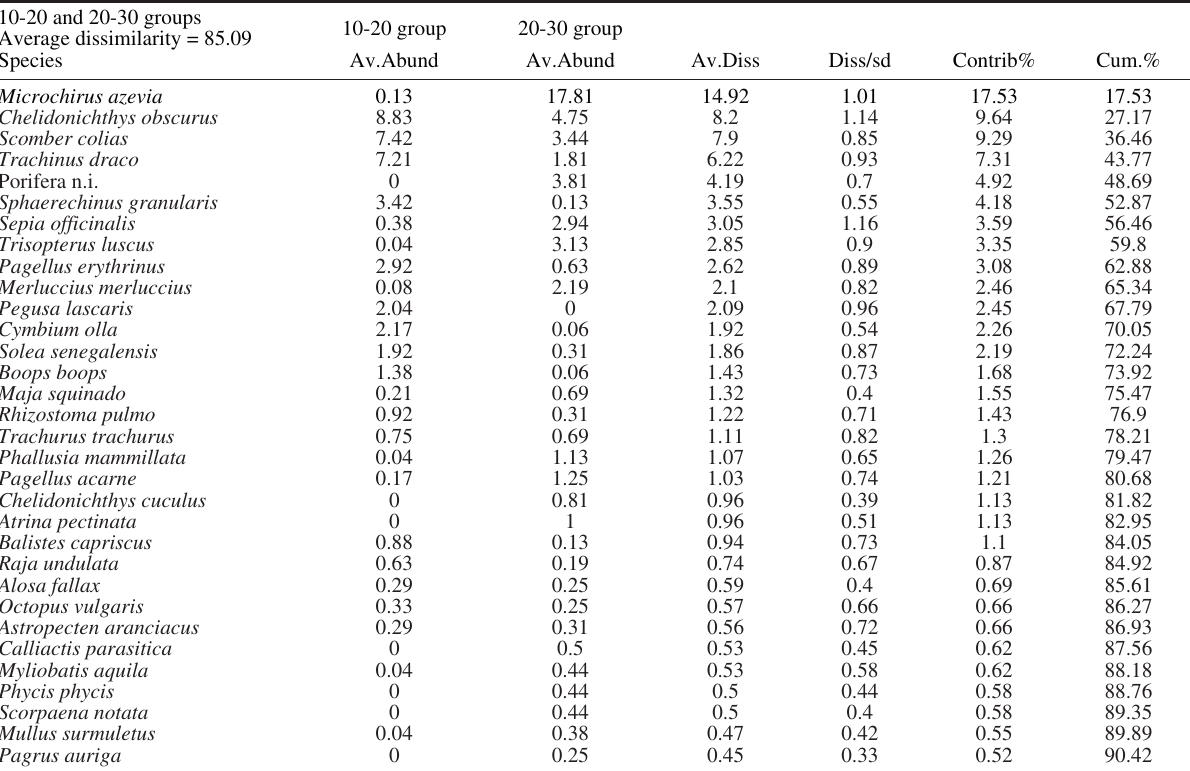
Table S6. – Simper analysis for the combined catch (commercial catch, commercial discards, and by-catch) data for abundance with the factor depth (10-20 m and 20-30 m). 10-20 and 20-30 groups Average dissimilarity =